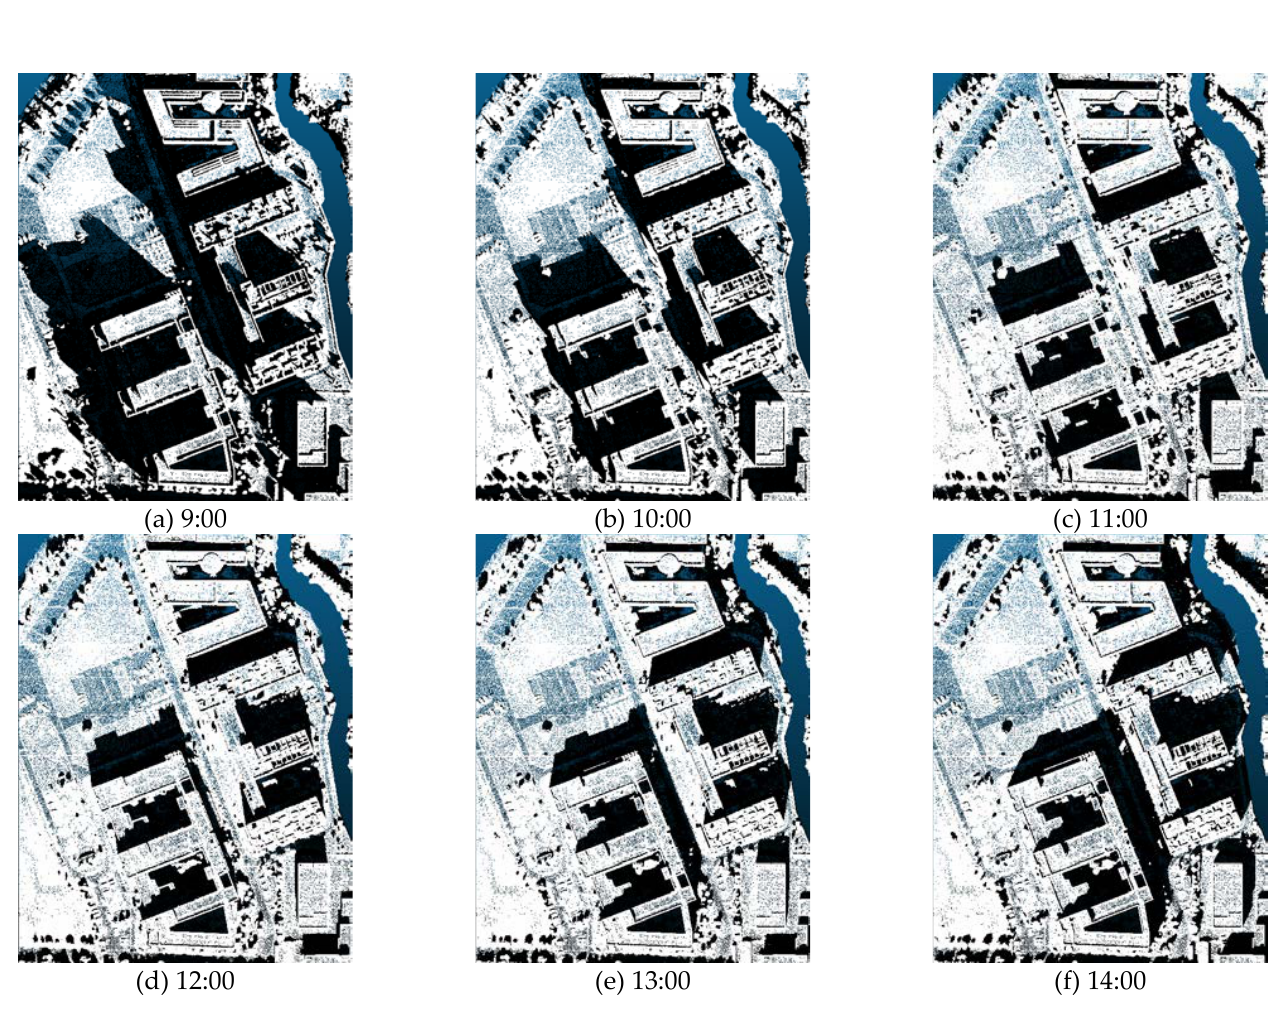
Figure 8. The shadows of the buildings during the winter solstice in 2019.